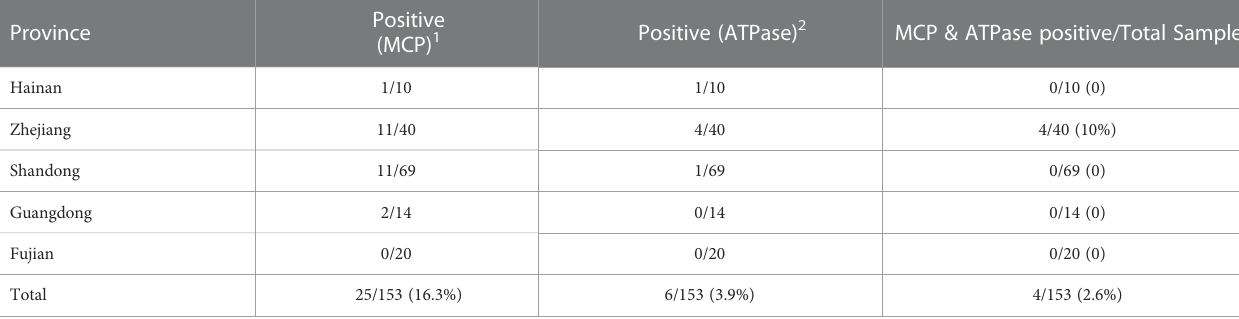
TABLE 2 DIV1 detection results of 153 Penaeus japonicus samples in some coastal provinces of China.